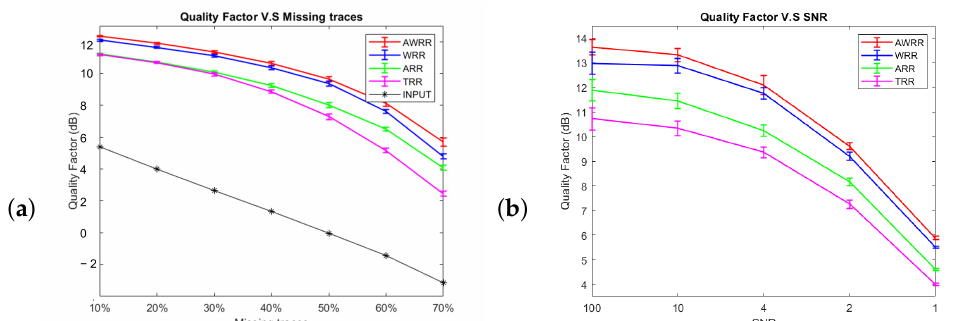
Figure 13. ( a ) The mean and standard error of the quality of reconstruction versus gap ratio for various methods. These results were obtained by running each method on 20 noise realizations of the dataset with different gap ratios and rank = 9 for the methods requiring a predefined rank. ( b ) The mean and standard error of the reconstruction quality versus SNR for various methods. These results were obtained by running each algorithm on 20 noise realizations of the dataset with a gap ratio = 50%, and rank = 9 for the methods requiring a predefined